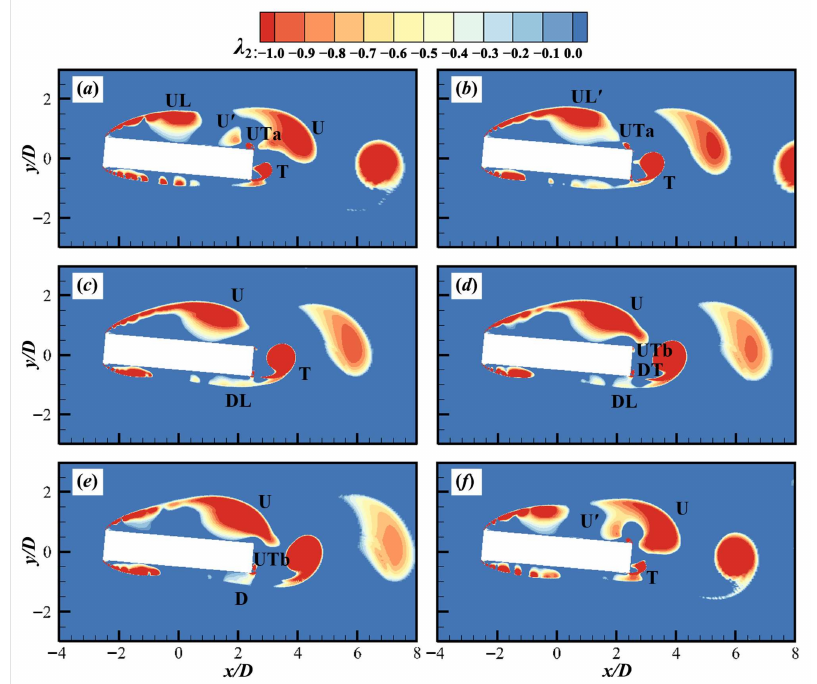
Figure 20. Vortex evolution within a vortex shedding period at α = 5 ◦ . ( a ) tU ∞ /D = 872.4, ( b ) tU ∞ /D = 874.2, ( c ) tU ∞ /D = 875.1, ( d ) tU ∞ /D = 876.0, ( e ) tU ∞ /D = 876.9, ( f ) tU ∞ /D =